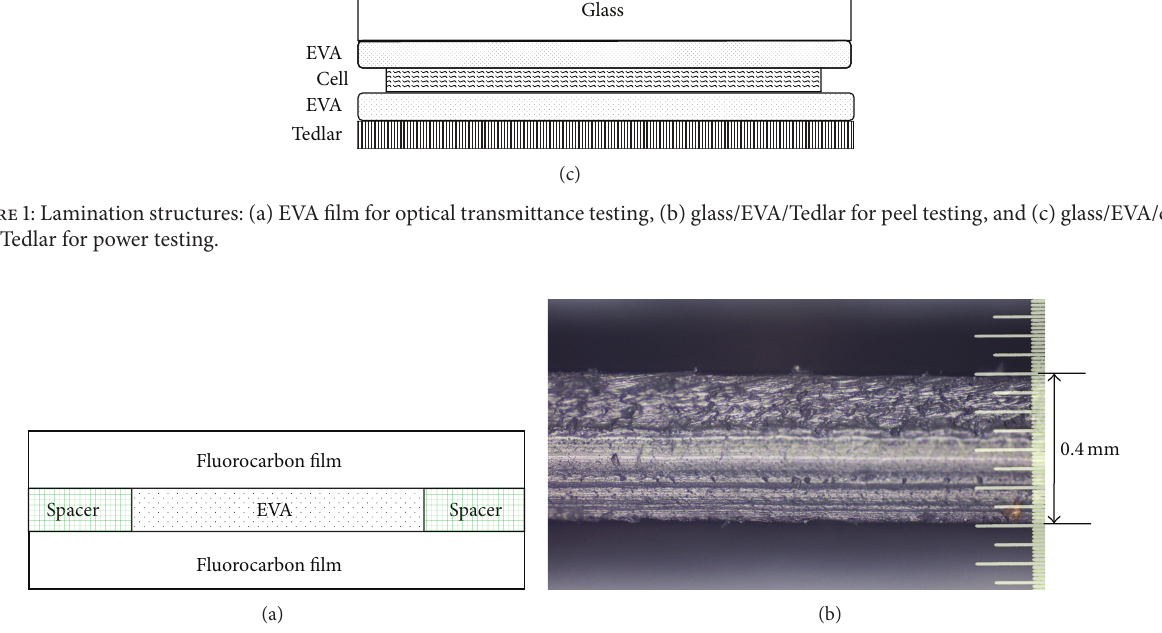
Figure 2: (a) The configuration of EVA film preparing. (b) The EVA film was observed by optical